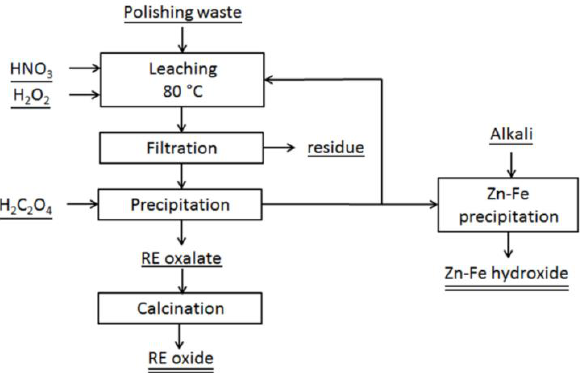
Figure 7. Flowsheet developed by Hydrometal for recovery of rare earth oxides from polishing waste by leaching followed by selective precipitation. Adapted from Henry et al. [27].